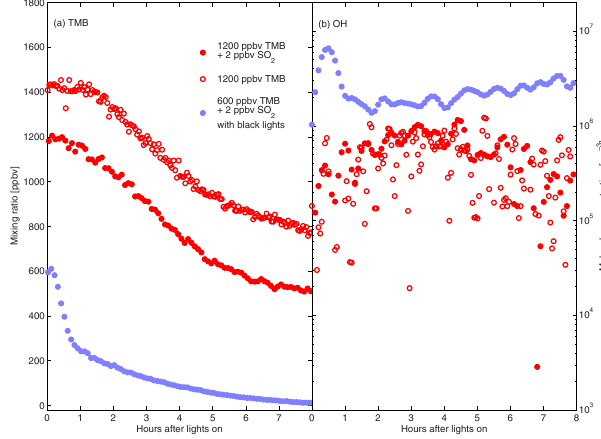
Figure 4. 1,3,5-Trimethylbenzene (TMB, a ) and derived hydroxyl radicals (OH, b ) concentrations for the different experiments. Filled symbols: with SO 2 ; open symbols: without SO 2 ; red: high conc.; blue: low